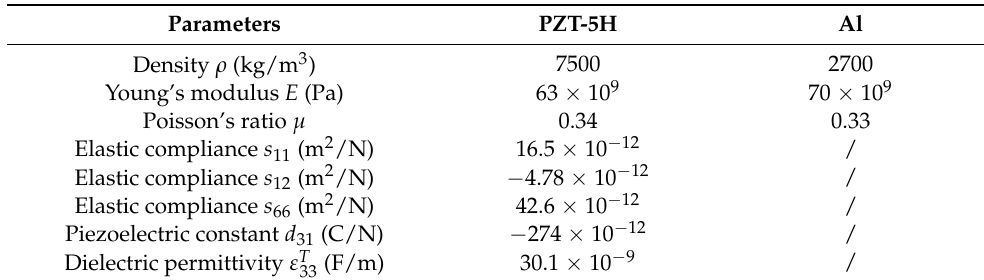
Table 2. Material parameters of the unit